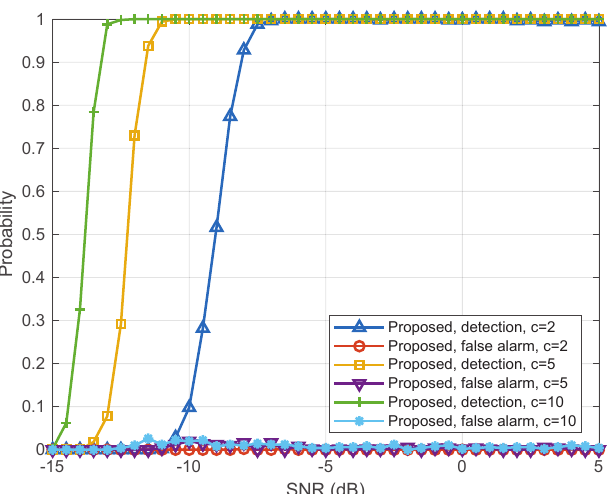
Figure 6. Effect of number of samples on algorithm performance when p b = 1, p e = 1, M = 256 and K = 16.